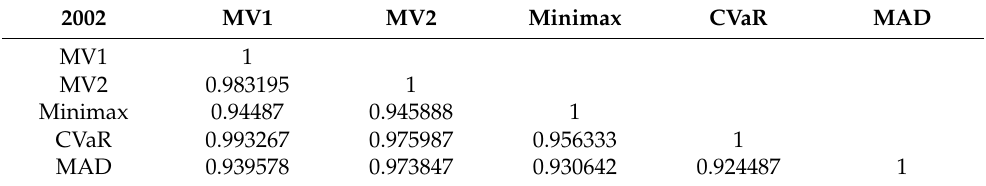
Table A3. Correlation coefficients among portfolio values based on “buy and hold” strategy in 2002.